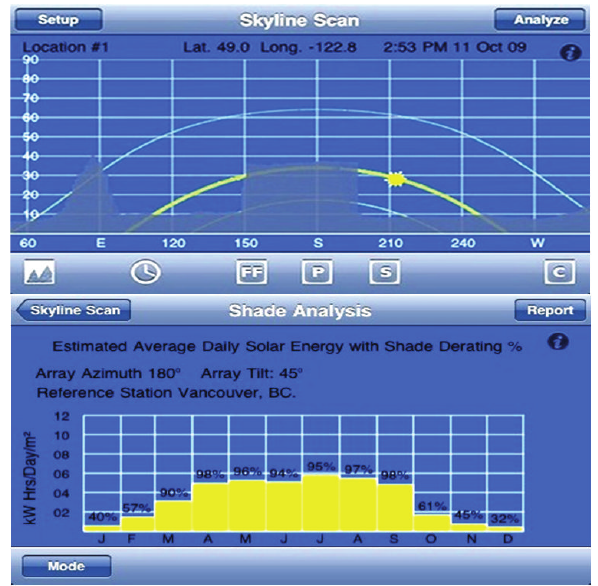
Figure 5: A typical skyline scanning and shading analysis by mobile phone.